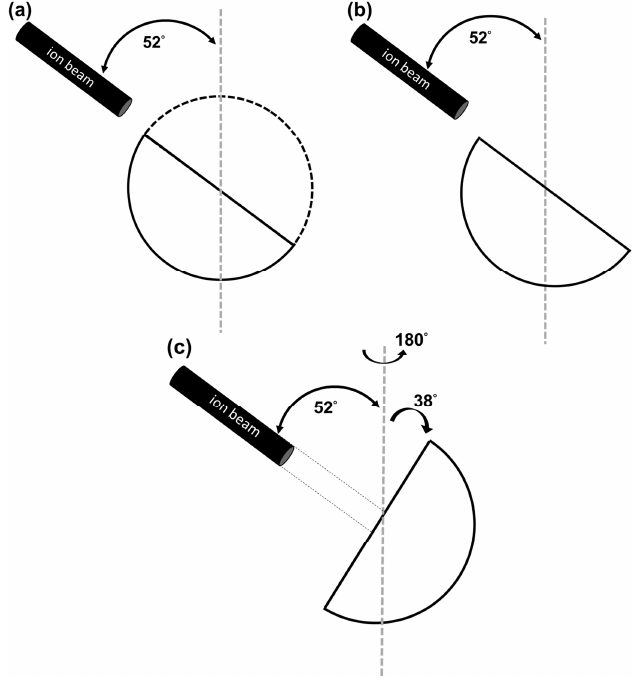
Figure 1. Preparation of micrograph using a focused ion beam: ( a ) ion bombardment along the longitudinal cross section of wire specimen; ( b ) after ion cutting; ( c ) secondary electron image taken from the ion beam.